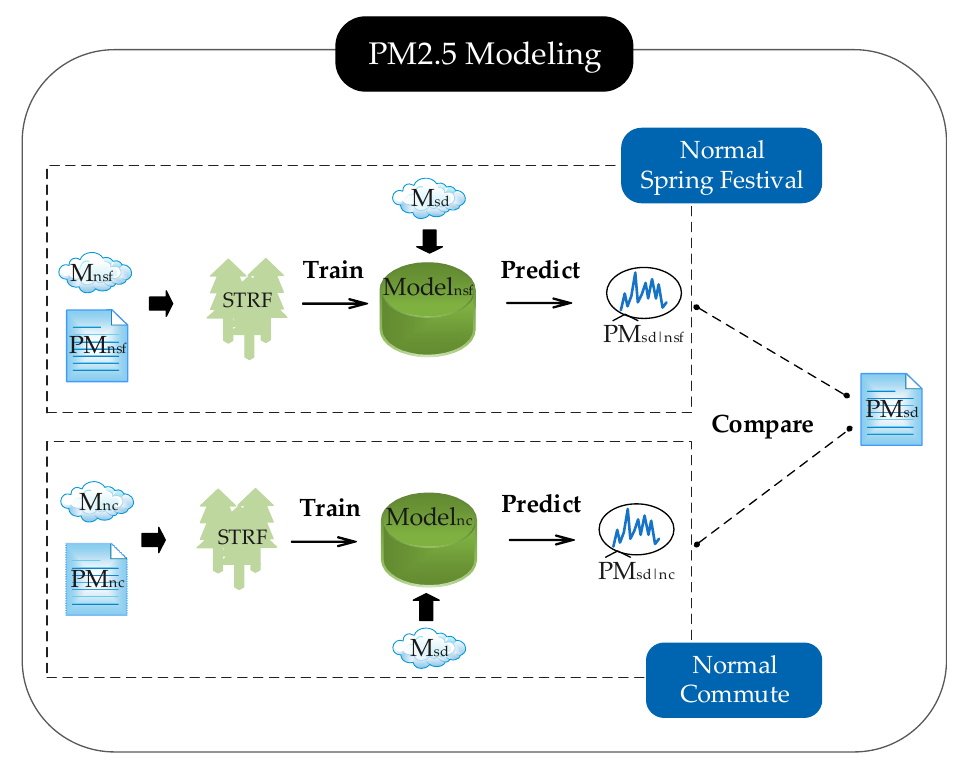
Figure 2. Workflow of PM 2.5 modeling. Table 2. Meteorological and emission background of PM sd , ˆ PM sd | nsf , and ˆ PM sd | nc .